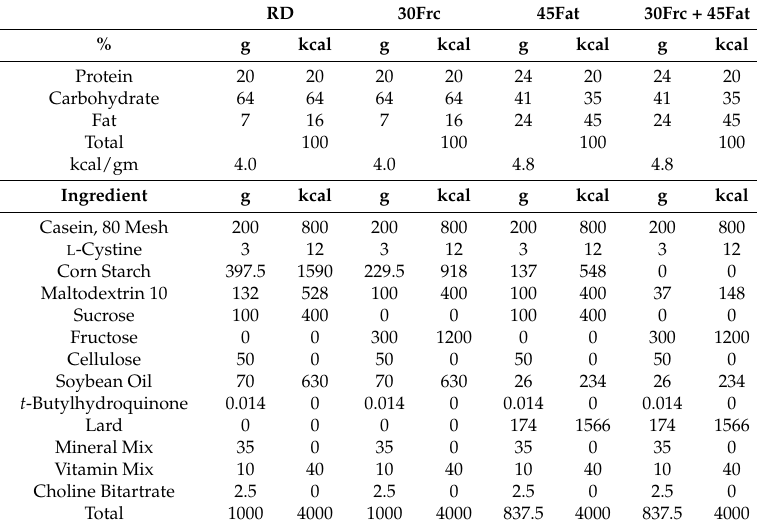
Table 1. Ingredient composition of experimental diets.